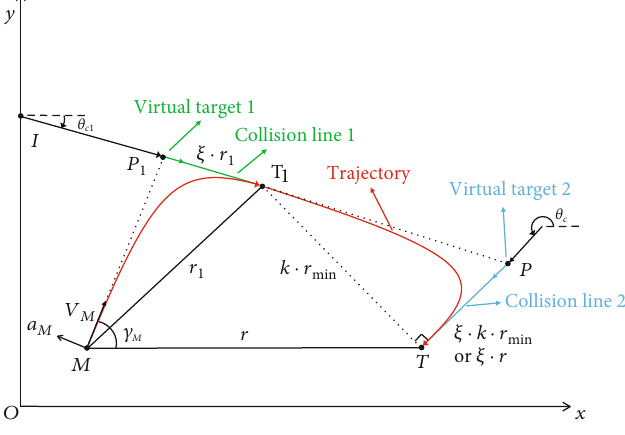
Figure 3: Omnidirectional attack.